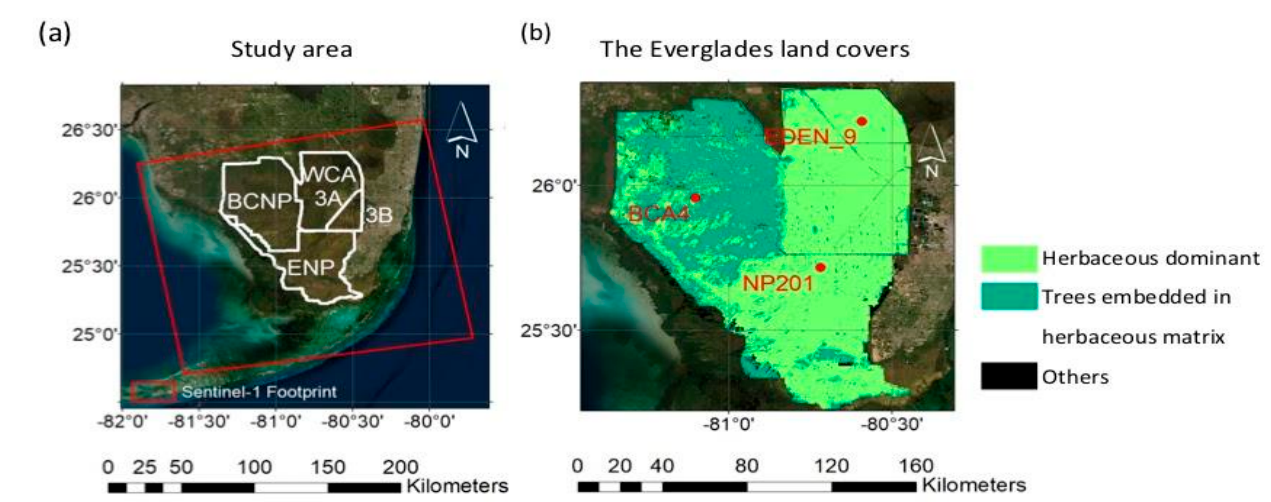
Figure 2. ( a ) Map of the study area in the Everglades according to the extent of EDEN water surface products, including four hydrological units (polygons with white boundaries). The red frame shows a Sentinel-1 SAR footprint. ( b ) The land cover map of the Everglades is derived from the South Florida Water Management District (SFWMD) Land Cover Use map for 2014–2016 (https://geo-sfwmd.hub.arcgis.com/datasets/sfwmd::sfwmd-land-cover-land-use-2014-2016/about, last accessed on 1 November 2021, with details provided in Supplementary Material Note 1). Red dots mark the locations of three selected EDEN water gauges presented in Section 5.1. (Background of both maps is the optical base map provided by ESRI, DigitalGlobe, GeoEye, Earthstar Geographics, CNES/Airbus DS, USDA, USGS, AeroGRID, IGN, and the GIS User Community).